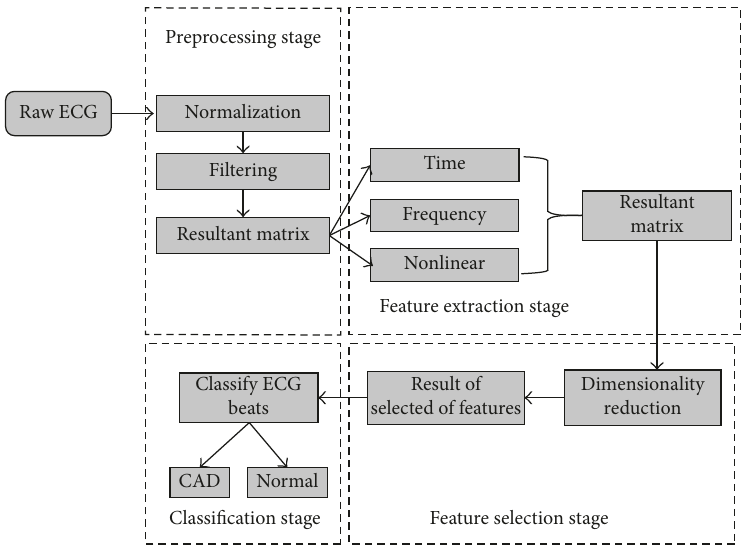
Figure 1: Workflow for parameter set A.